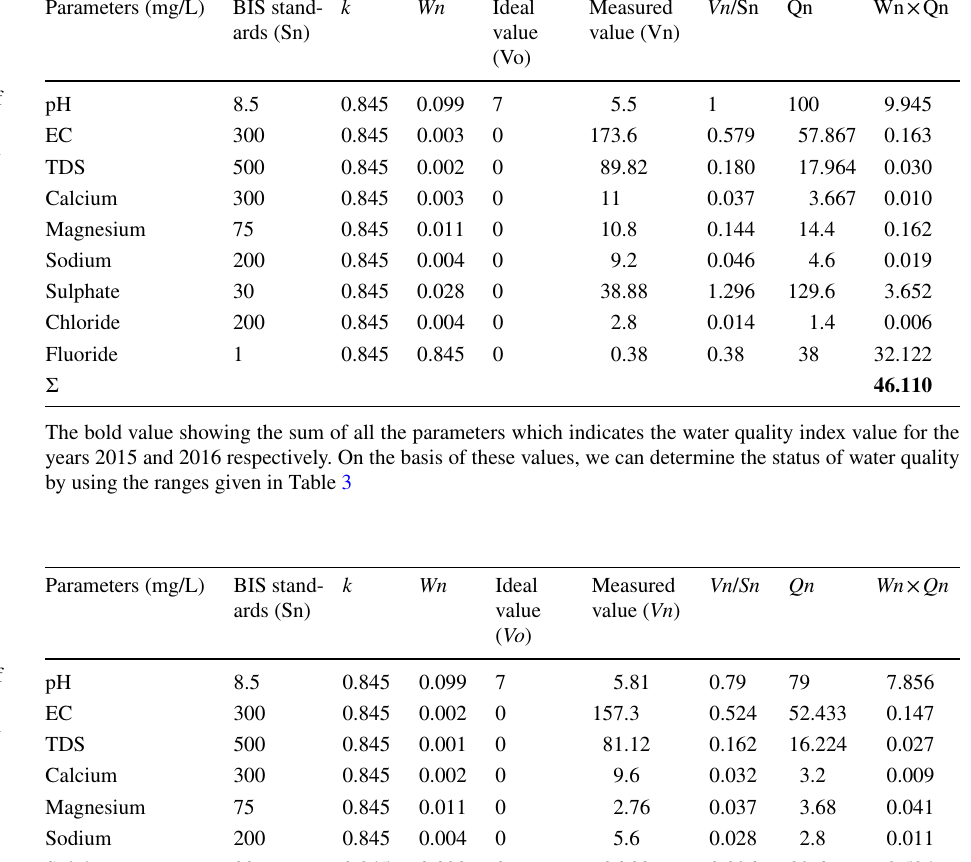
Table 1 Estimation process